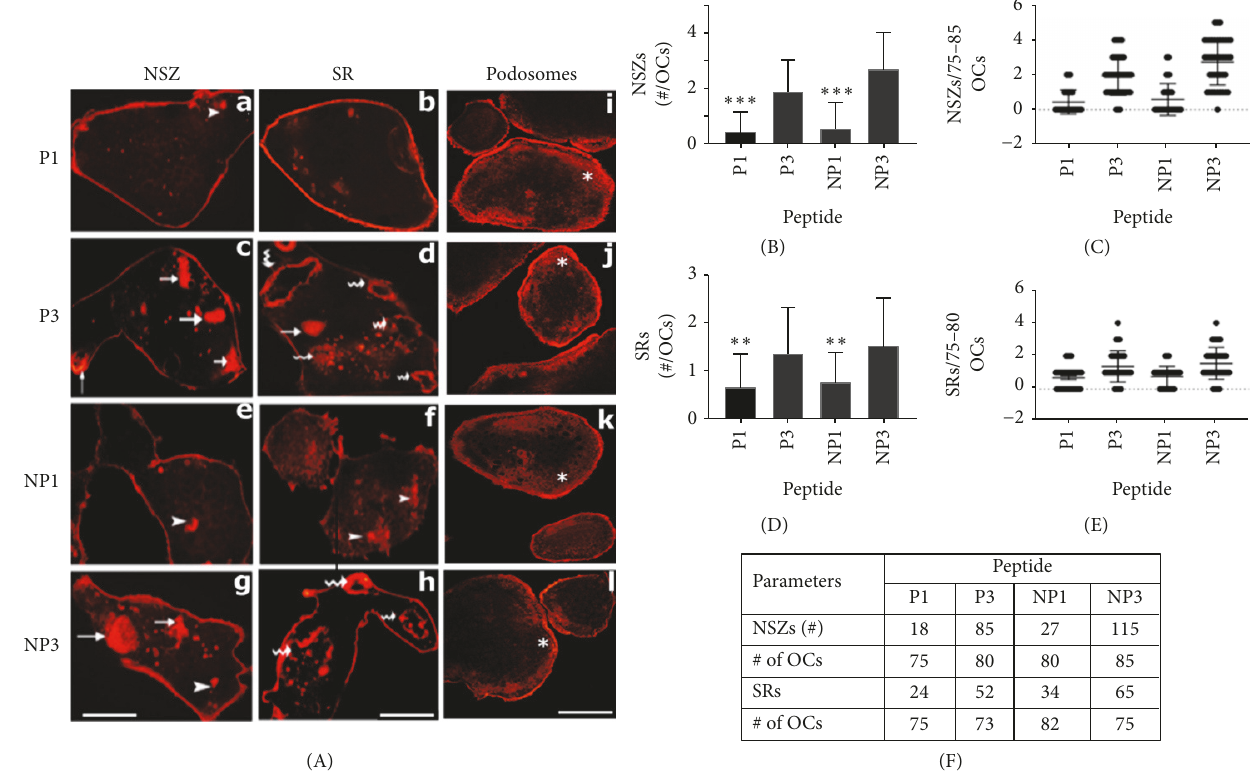
Figure 6: Confocal microscopy analyses of osteoclasts stained for filamentous (F-) actin with phalloidin . (A) Actin staining of osteoclasts with rhodamine phalloidin: osteoclasts were transduced with TAT-fused sNT-LPL peptides (P1—panels a, b, & I; P3—panels c, d, & j) or treated with nanoparticles loaded with peptides (NP1—panels e, f, & k; NP3—panels g, h, & l). After treatment cells were stained for actin (red) to determine the formation of nascent sealing zones (NSZs) and sealing rings (SR). Arrowheads point to actin punctate stainings; arrows point to NSZs; wavy arrows point to mature sealing rings. Osteoclasts plated on coverslips and treated as indicated above with peptides, and bone particles were stained with rhodamine phalloidin. An asterisk indicates podosome localization at the cell periphery. Scale bar 150 𝜇 m. These results represent one of the three experiments performed with similar results. (B)-(F) Statistical analyses of the number of NSZs and sealing rings (SRs). The number of NSZs and SRs was counted in 75-80 osteoclasts from three experiments and presented as graphs (B=E) and table (F). The treatments are shown below each graph. The number of NSZs and SRs is presented per osteoclasts in graphs shown in (B) and (D). Data are also given as scatterplots for the indicated number of osteoclasts ((C) and (E)). The total number of NSZs and SRs is also provided for the indicated peptides and the number of osteoclasts in Table (F). The effect of P1 or NP1 is significant in the inhibition of NSZs and SRs as compared with respective control groups (P3 or NP3). ∗∗ p < 0.01; ∗ ∗ ∗ p < 0.001 versus respective control groups (P3 or